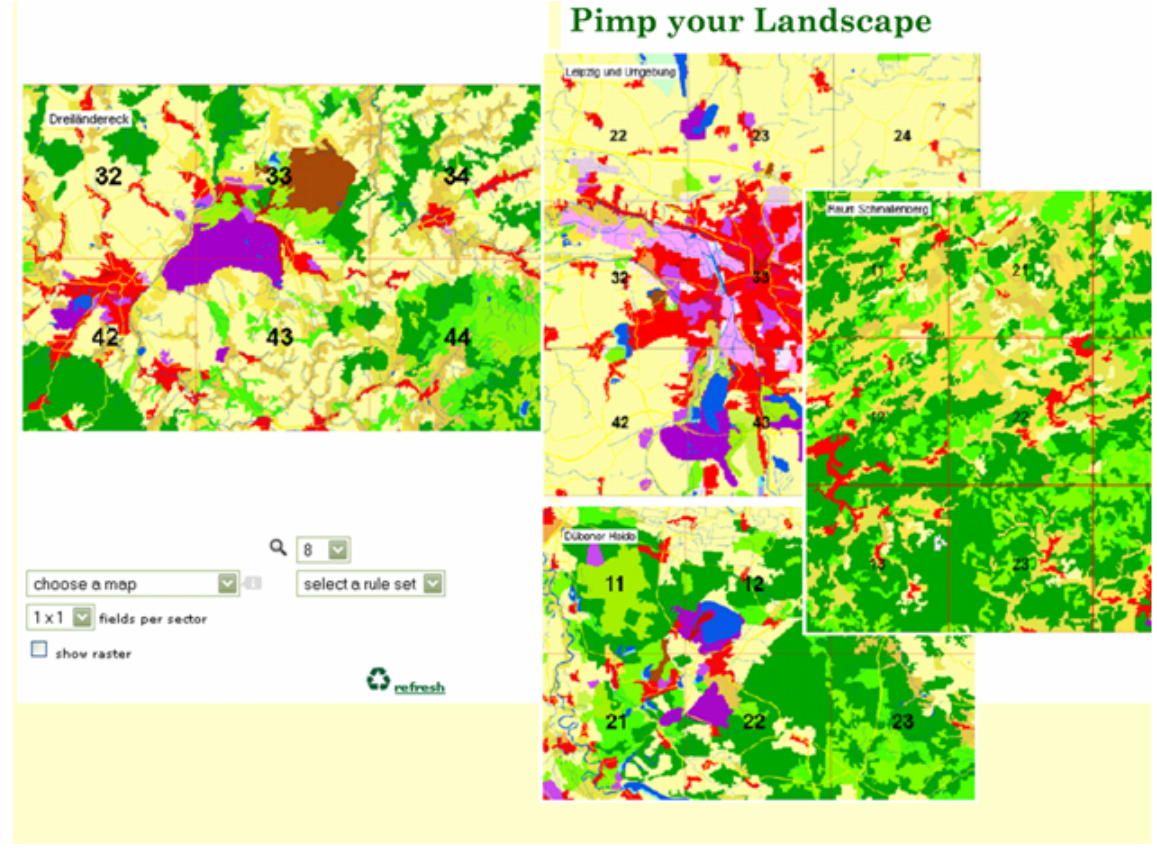
Fig. 3 . Home page of Pimp your landscape , displaying some of the model regions, which are already integrated into the